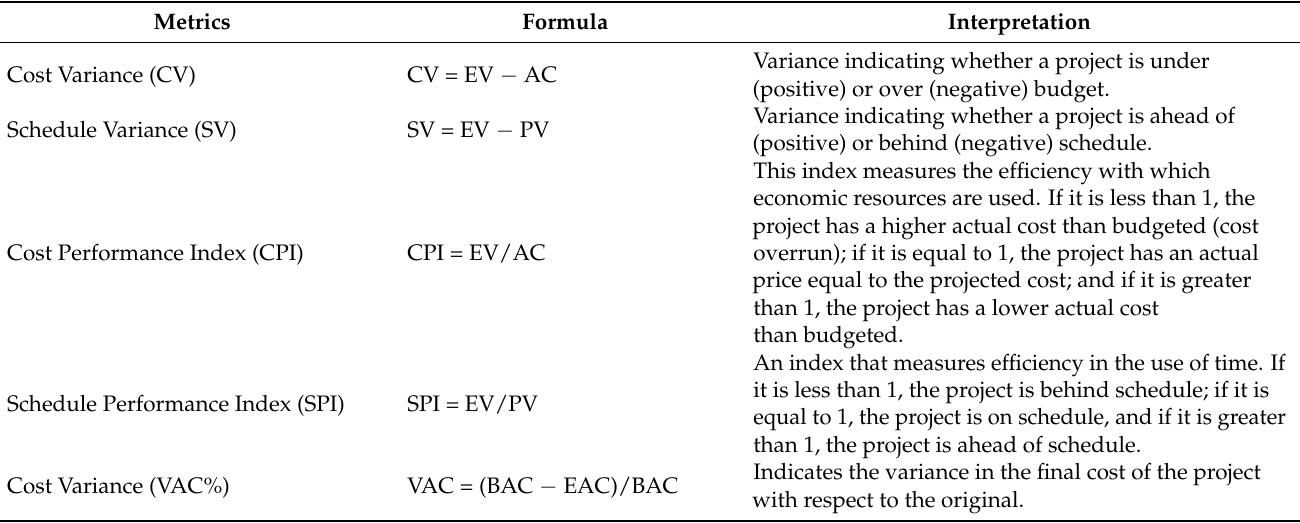
Table 2. Performance indicators and variances in the EVM technique